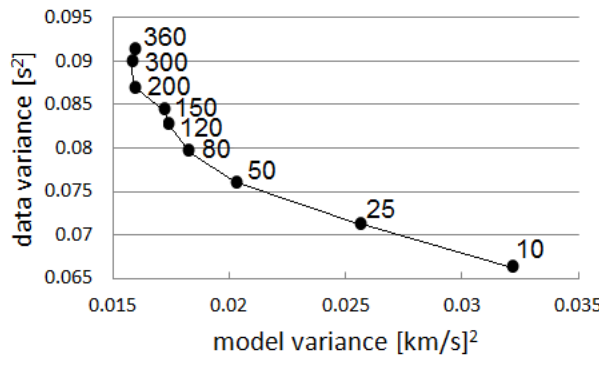
Figure 4. Trade-off between the data variance and model variance obtained with different damping values from 10 to 360. The pre- sented results were obtained using a damping value of 120.